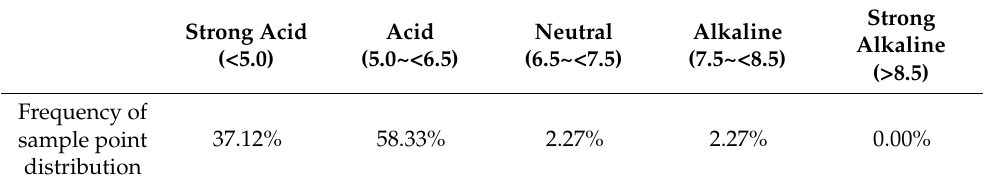
Table 3. Distribution of acidity and alkalinity at sampling